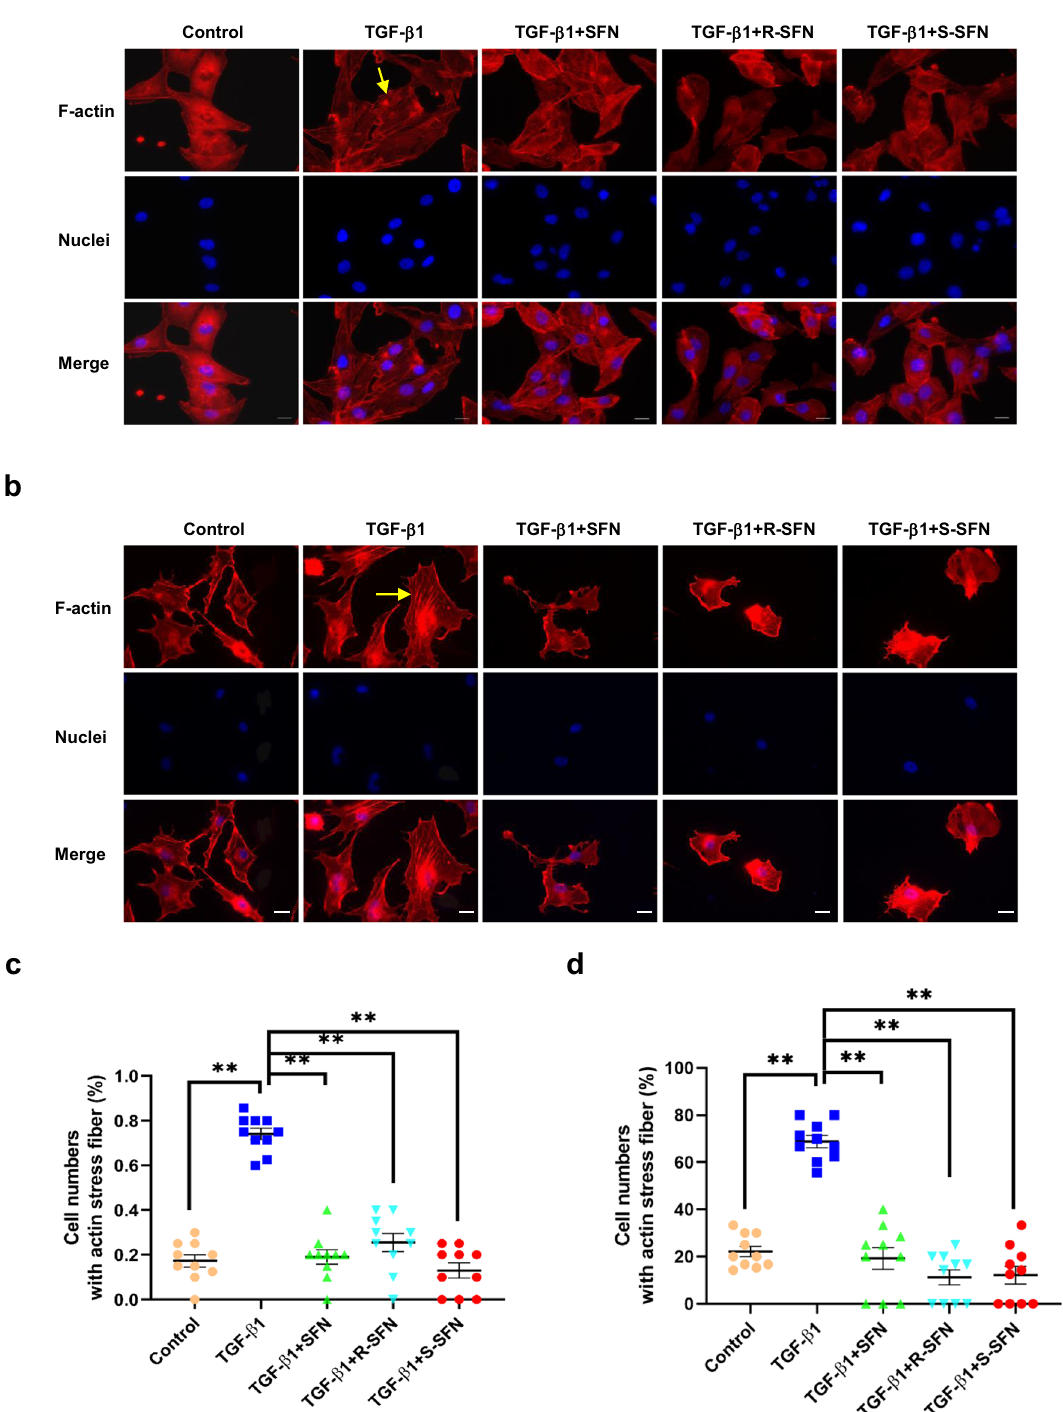
Fig. 6 SFN inhibits TGF- β 1-induced actin stress fi ber formation. a , b Representative images showing the effect of SFN, R-SFN, and S-SFN on TGF- β 1-induced actin stress fi ber formation in MDA-MB-231 ( a ) and MDA-MB-157 ( b ) cells. Yellow arrows label the cells with remarkable actin stress fi ber formation. Scale bar = 20 μ m. c , d Statistical assay showing the effect of SFN on TGF- β 1-induced actin stress fi ber formation in MDA-MB-231 ( c ) and MDA-MB-157 ( d ) cells. Ten fi elds of view were randomly selected and then the ratio of the cells with actin stress fi ber formation in each group was calculated. At least 60 cells in three independent experiments were counted. Data shown are mean ± SEM. ** P <